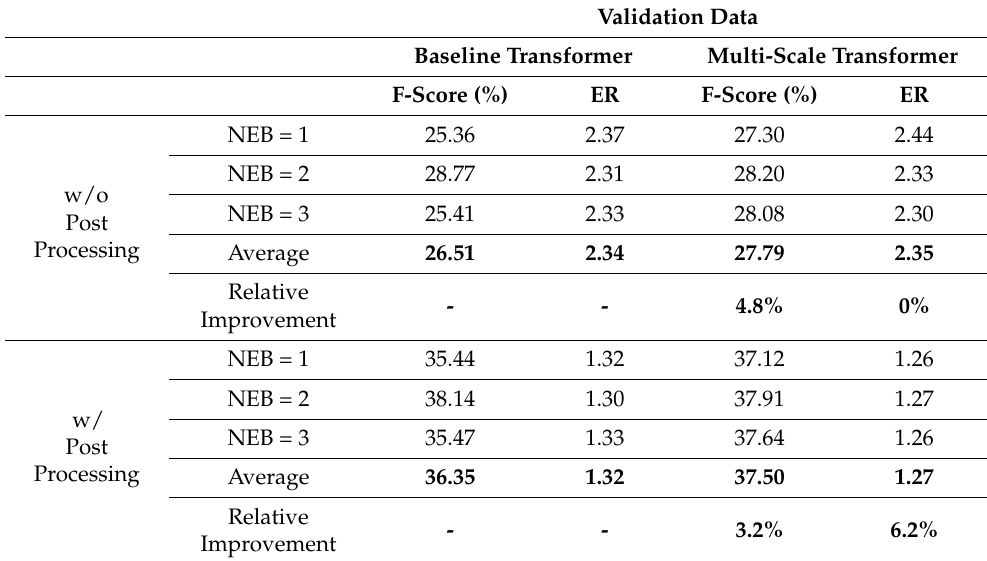
Table 3. Comparison of event-based SED results on validation data between baseline Transformer model and multi-scale Transformer